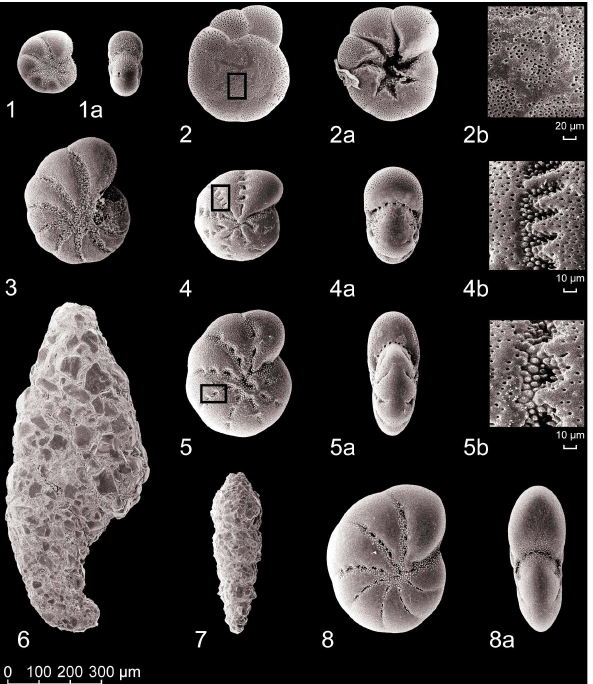
Fig. 6. Benthic foraminifera from Flensburg Fjord. 1 Elphidium al- biumbilicatum : spiral (1) and apertural (1a) views; 2 Ammonia ao- moriensis : spiral (2), umbilical (2a) and detailed view of the